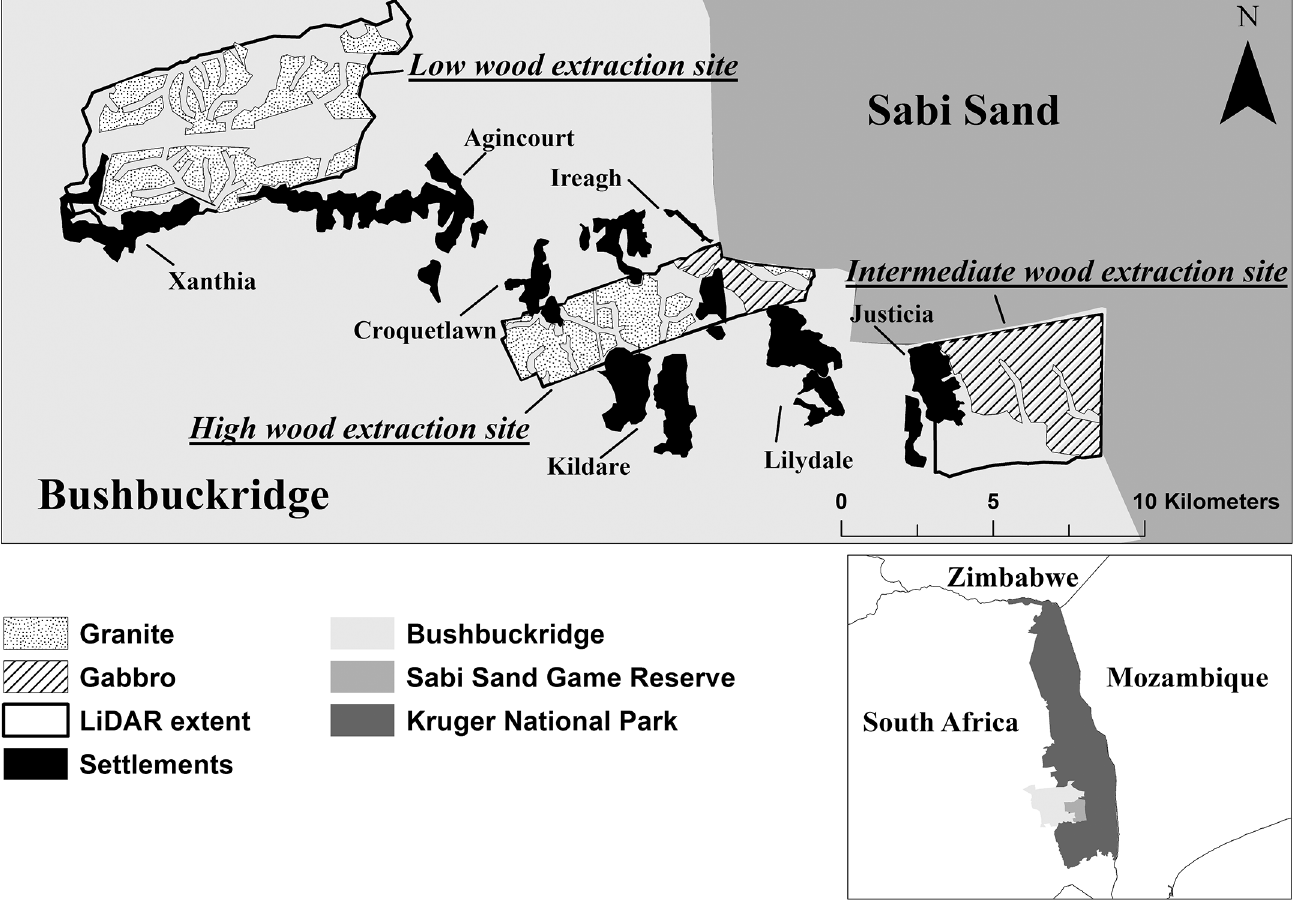
Fig 1. Study sites in Bushbuckridge municipality, located in the South African Lowveld. Sites are classified (from west to east) as low, high and intermediate wood extraction pressure based on the number of households and people utilising each rangeland. Settlements that utilise each rangeland are shown, including the names of the major settlements, as well as the location of the gabbro intrusions in the predominantly granitic landscape.